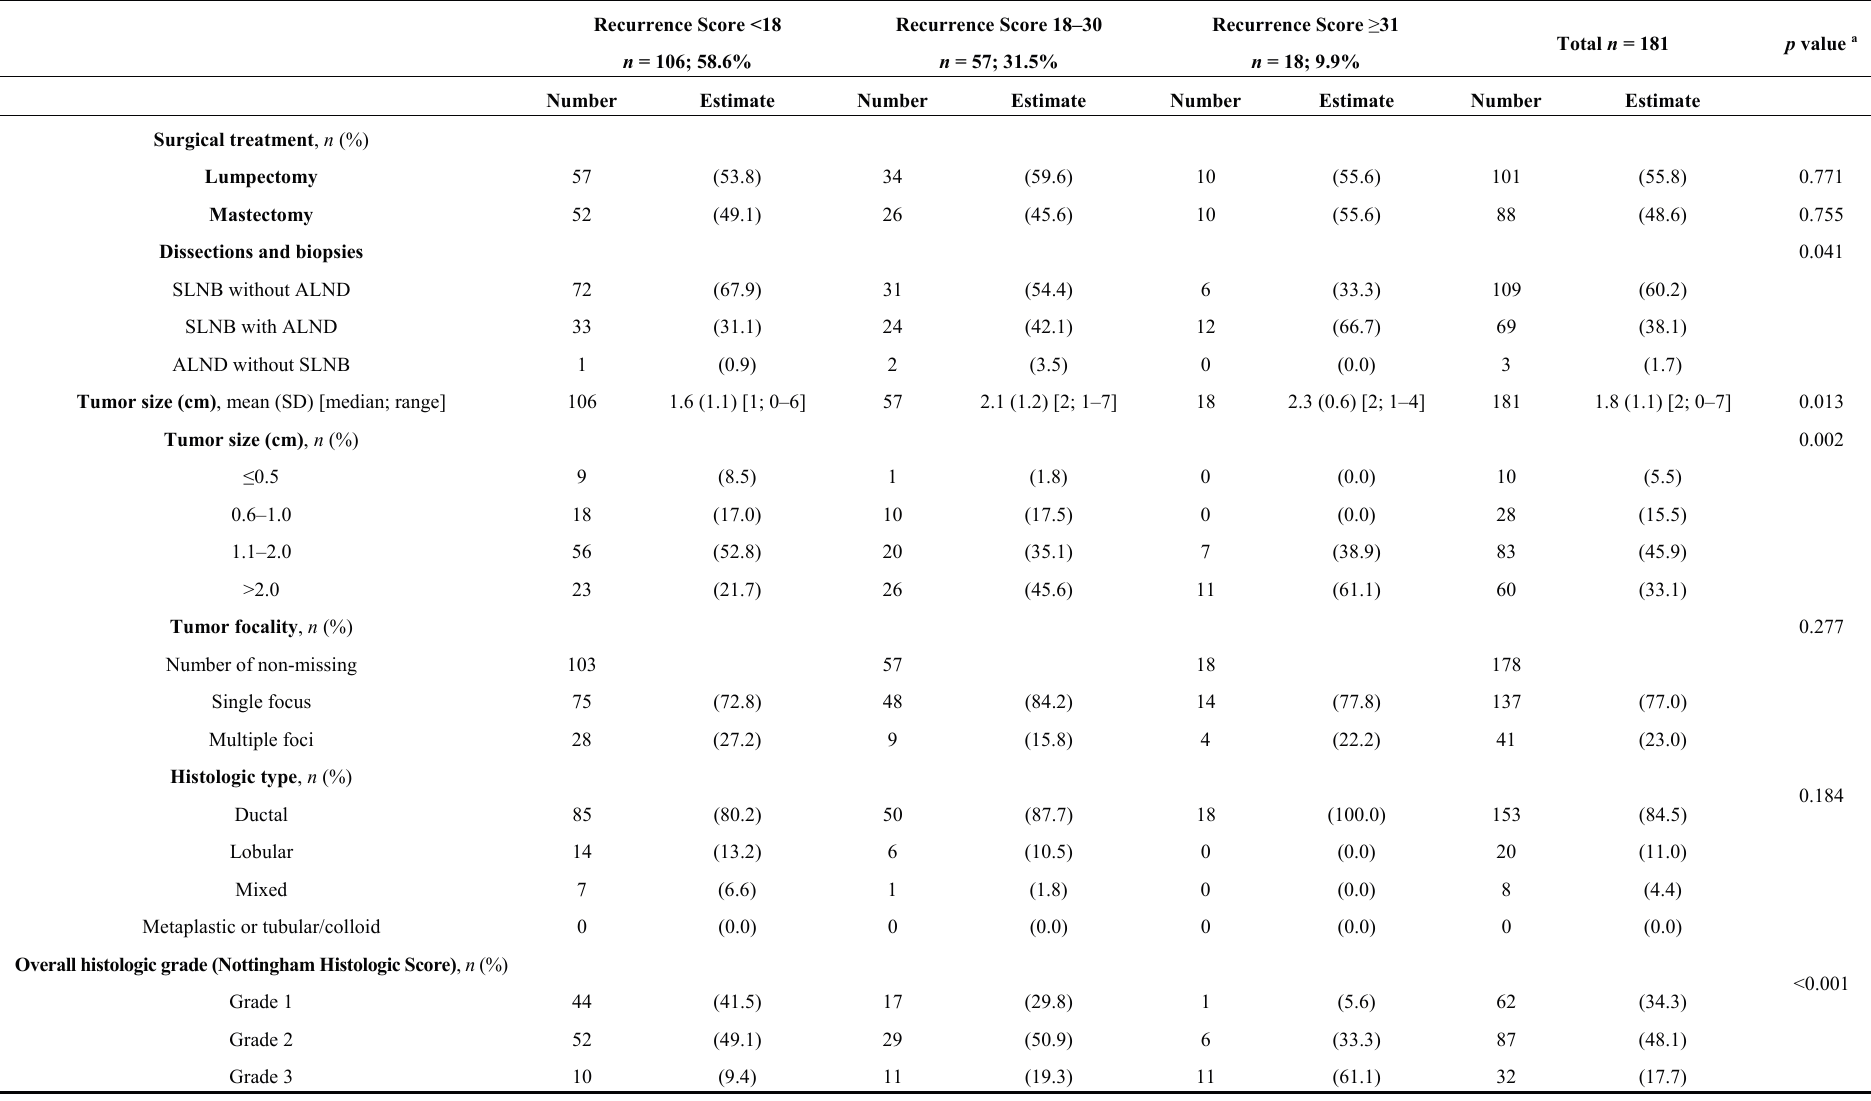
Table 2. Surgical treatment and tumor histopathologic characteristics by Recurrence Score result